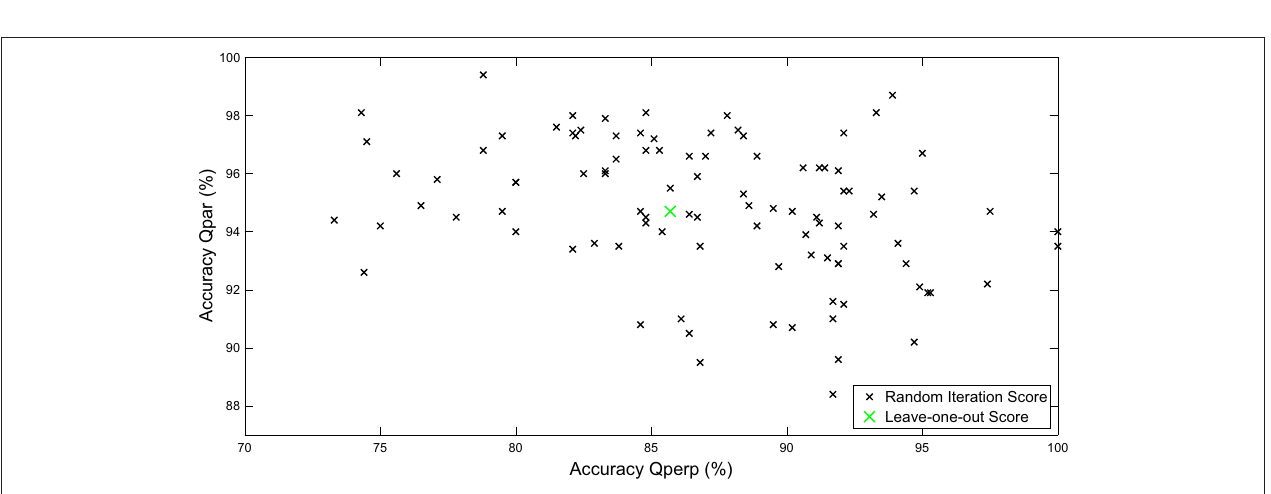
FIGURE 8 | Accuracy of the neural network for 100 random initialization of training/test set, with every point being one iteration. The x-axis represents the accuracy in quasi-perpendicular class and ranges from 70 to 100%. On the other hand, the y-axis shows the accuracy in the quasi-parallel class and ranges from 88 to 100%. Special indication of the leave one out result is marked in green color. The training of the shown neural networks does not include the IMF